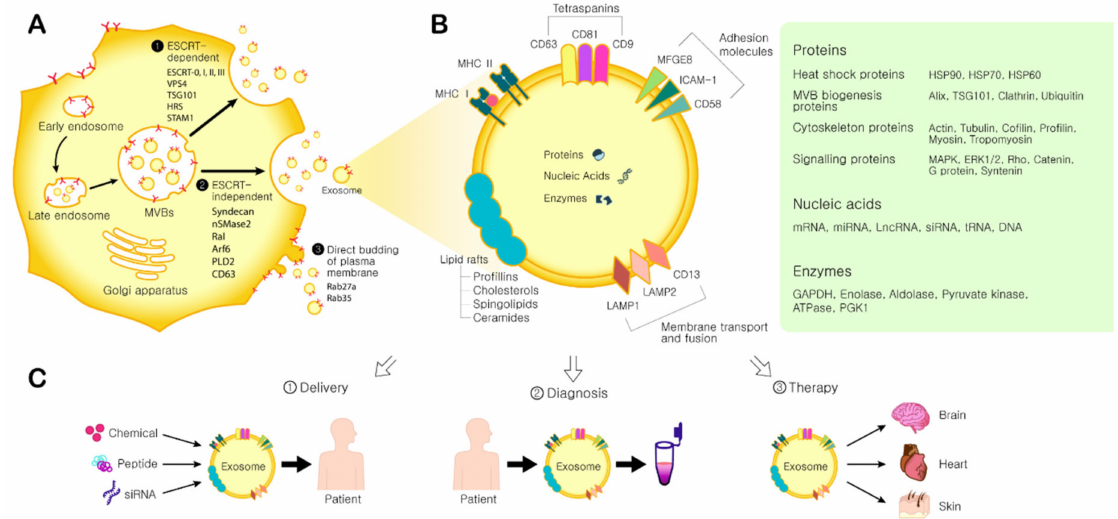
Figure 1. Exosome biogenesis and its application. ( A ) Exosome biogenesis. Three pathways for exosome biogenesis. ( (cid:202) ) ESCRT-dependent pathway and related proteins, ( (cid:203) ) ESCRT-independent pathway and related proteins, ( (cid:204) ) Direct budding of plasma membrane and related proteins. ( B ) Exosome components. MFGE8: milk fat globule-EGF factor 8 protein; ICAM-1: intercellular adhesion molecule 1; LAMP1,2: lysosomal-associated membrane protein 1,2; MHC I, II: major histocompatibility complex I, II. MAPK: mitogen-activated protein kinase; ERK: extracellular signal-regulated kinase; GAPDH: glyceraldehyde 3-phosphate dehydrogenase; PGK1: phosphoglycerate kinase 1. ( C ) Applications of exosomes. ( (cid:192) ) Drug delivery: Therapeutic agents such as chemicals, peptides, and siRNAs